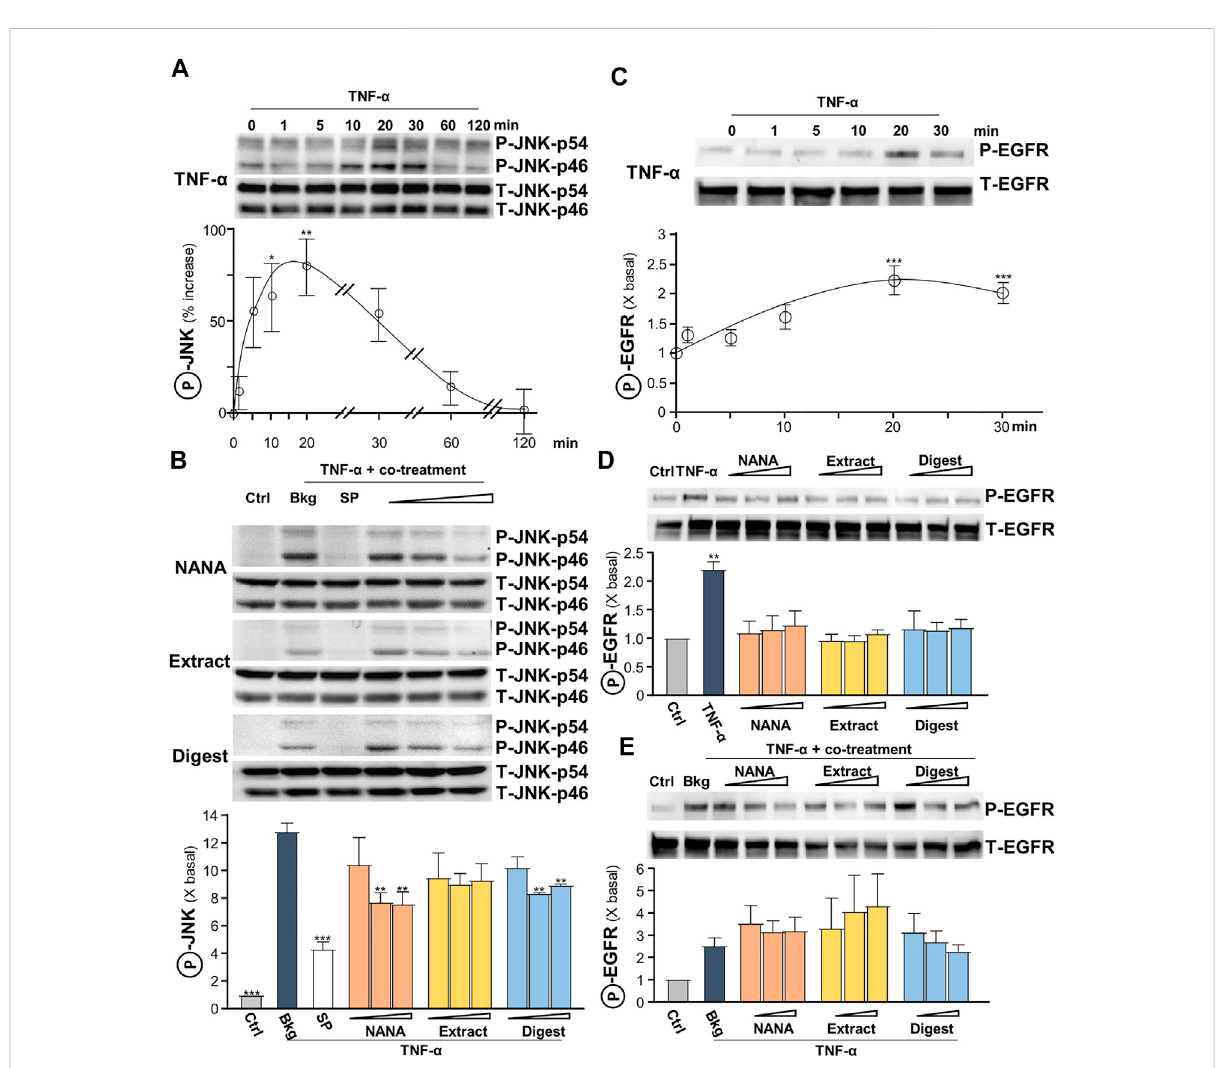
starvation, cultured HaCaT keratinocytes were induced by TNF- α (20 ng/mL) at a period of 0 – 2 h. The values of p-JNK/JNK expression levels at different time points are shown. (B) After 16-h serum starvation, TNF- α together with EBN preparation were applied for 20 min. SP600125 (a JNK inhibitor; 10 nM), NANA (0.05, 0.1, 1 mM), EBN extract and digest (both at 1, 10, 100 μ g/mL) are indicated. Total JNK (T-JNK-p46 and T-JNK- p54 for isoforms at 46 and 54 kDa respectively) and phosphorylated JNK (P-JNK-p46 and P-JNK-p54 for isoforms at 46 and 54 kDa,